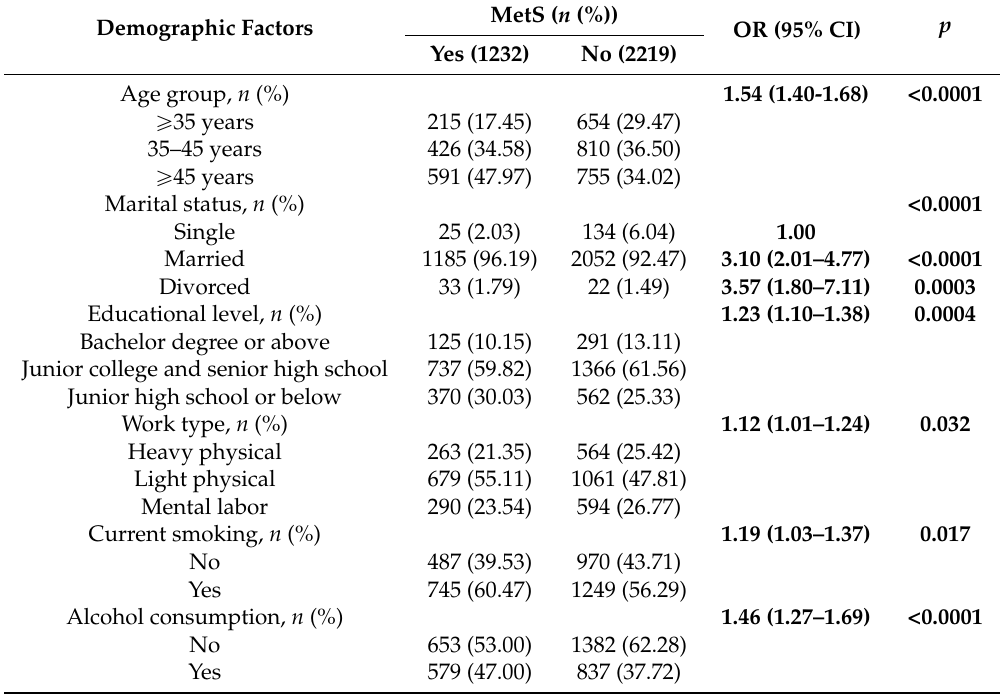
Table 1. The descriptive statistics of demographic factors and their association with Metabolic syndrome